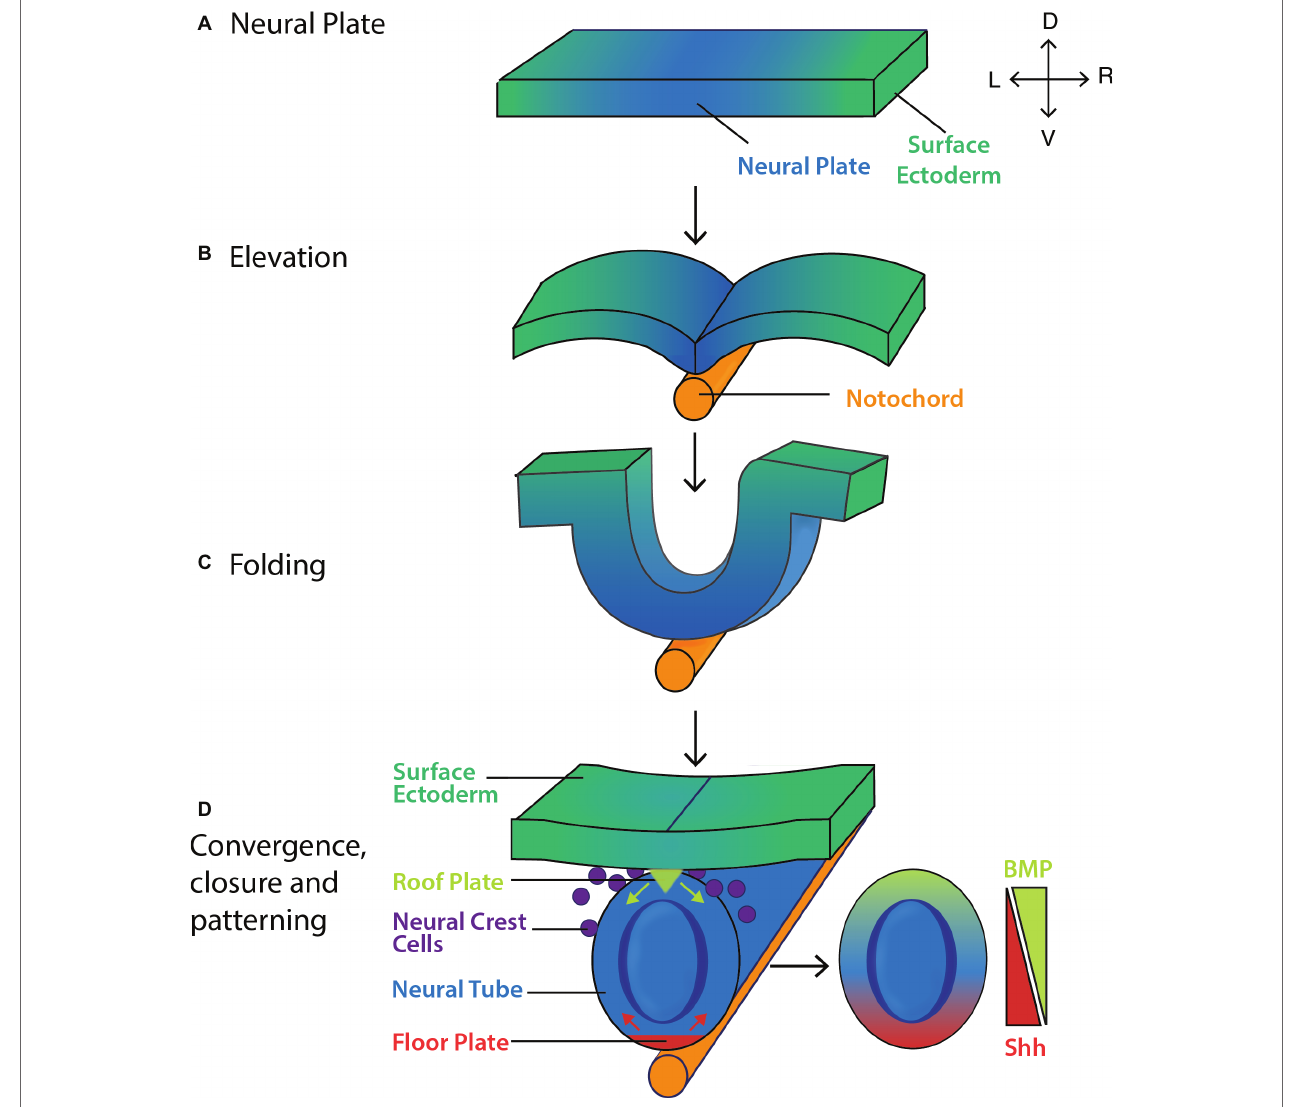
FIGURE 4 | Formation and patterning of the mouse neural tube. (A) The pseudostratified columnar epithelium of neural plate forms by 7.5 dpc. The lateral edges of the neural plate then (B) elevate and (C) fold by ~8.0 dpc before (D) converging at the midline and closing by ~8.5 dpc. Shh (red arrows) and BMP inhibitors secreted from the floor plate, and BMP4/7 (green arrows) secreted from the roof plate act to pattern the neural tube along its ventro-dorsal axis, giving rise to the layers of the spinal cord (Gilbert, 2006). Key: V, ventral; D, dorsal; L, left; R,